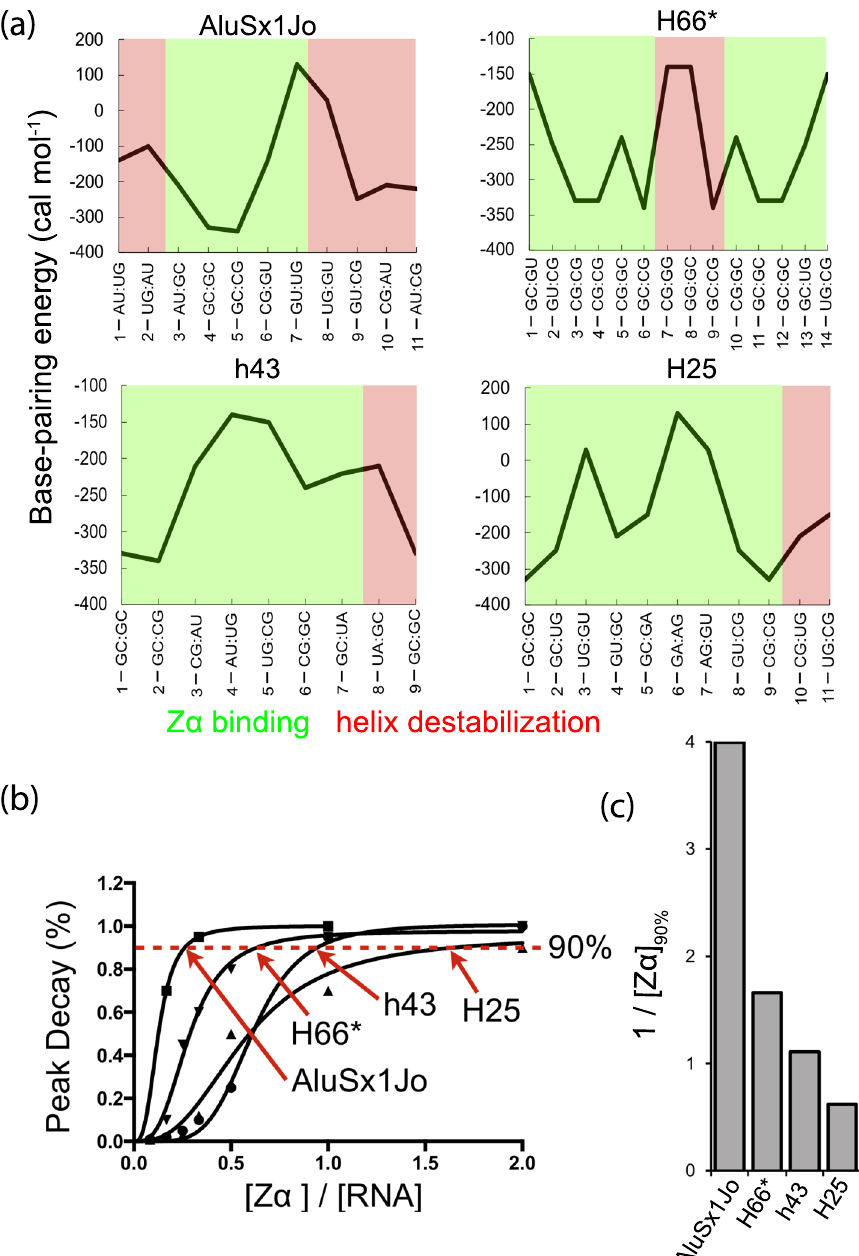
Fig. 4 Destabilization of RNA helices by Z α correlates to base-pair stability. a Regions identi fi ed as either being bound (green) or destabilized (red) by Z α (referring to Fig. 3) are overlayed onto the predicted base-pair free energy (RNAeval 46 ). b Imino peak height for proton signals in AluSx1Jo, H66* (extended duplex), h43, and H25 RNAs which are destabilized due to Z α -binding are shown versus Z α concentration. c The inverse of the Z α concentration at which 90% of the imino signals disappear into the noise is shown. Peak heights in b are from 1D NMR titrations (one measurement for each